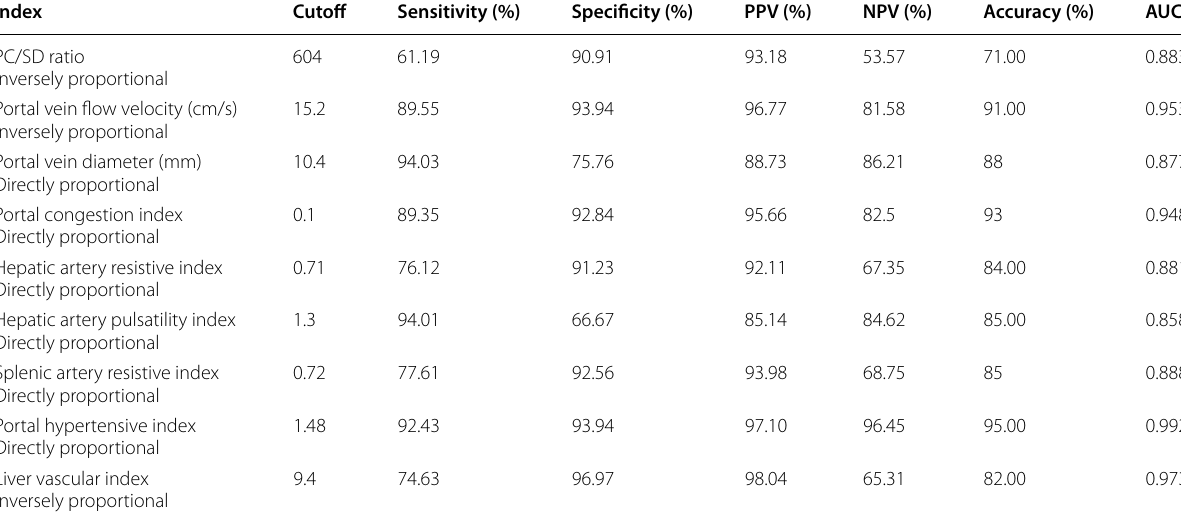
Table 8 Accuracy of PC/SD ratio and portal hemodynamic indices in prediction of esophageal